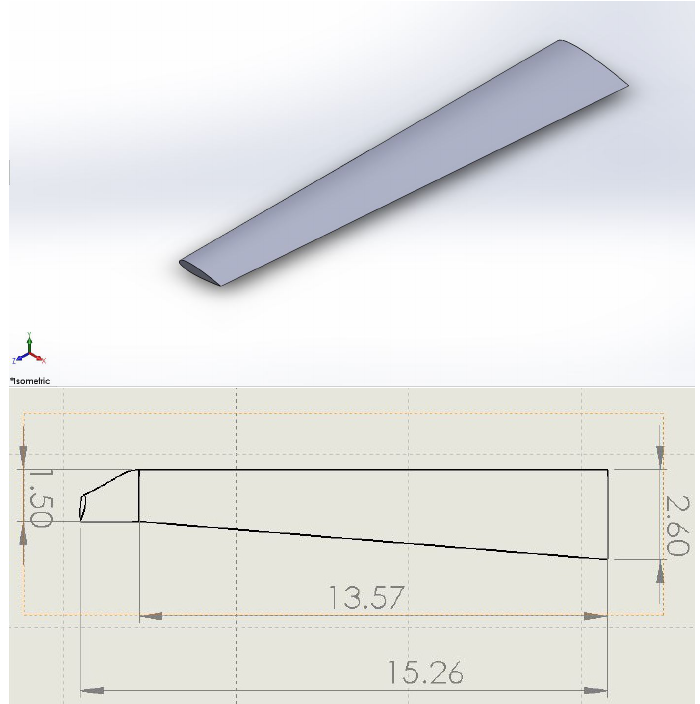
Figure 4. ATR 72 base wing and with